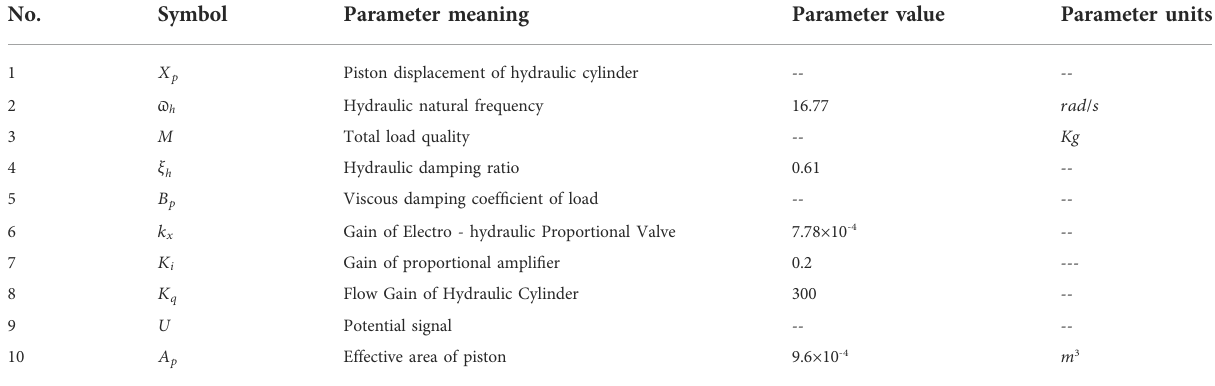
roof bolter, the ground training and industrial tests were carried out in the underground roadway, as shown in Figure 17 and Figure 18. The test platform is the underground roadway, with a section height of 2.8 – 4 m, a width of 3.8 – 5.6 m, a maximum inclination of 20 ° , and a maximum drilling depth of 8.3 m. All of them are in a gas-free working environment. The test lasted a total of 9 days. In the fi rst test, there were 14 anchor cable holes of 8.3 m, with a total of 116 m; 46.3 m anchor cable holes, 25 m in total; 124 m anchor cable holes, 48 m in total. In the second test, there were 6 anchor cable holes of 4 m, with a total of 24 m; 6.3 m anchor cable holes, totaling 37 m; 122.5 m anchor cable holes, 30 m in total.